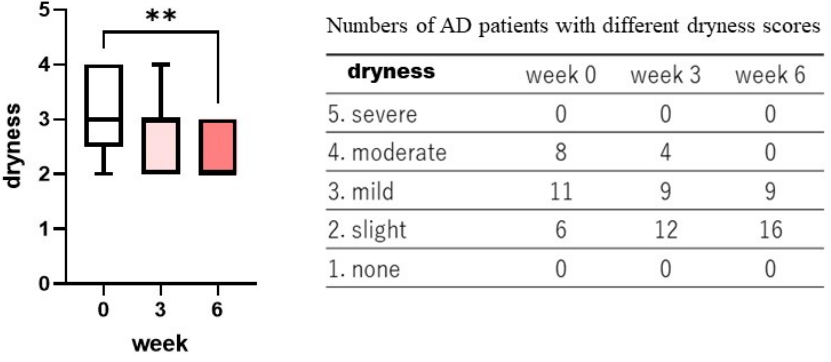
Figure 1. Clinical effects of the POLG nano-emulsion on the dryness of the skin of AD patients. Dryness scoring was performed by a dermatologist (KN) at 0, 3, and 6 weeks on a 1–5 grading basis (1 = none; 2 = slight; 3 = mild, 4 = moderate; 5 = severe). n = 25; **: p < 0.01 compared to week 0; all data were analyzed using Dunn’s multiple comparisons test.